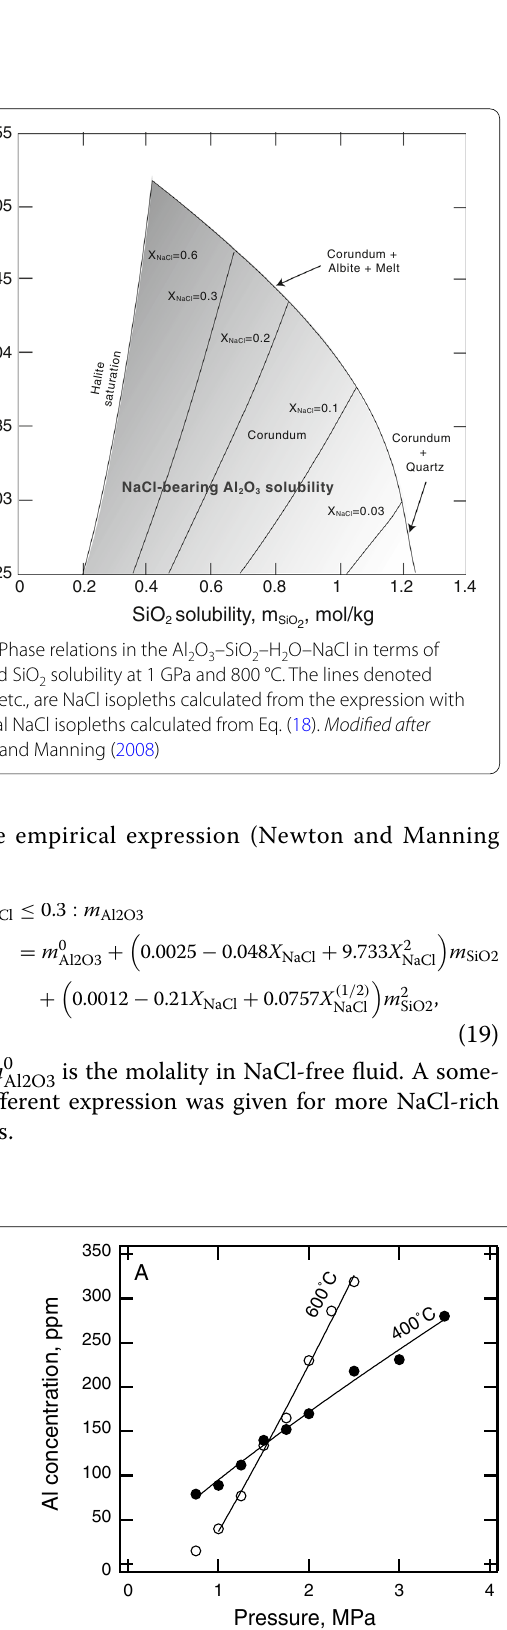
Fig. 21 Solubility in the system NaAlSi 3 O 8 –H 2 O A. Concentration of Al in fluid as a function of pressure at temperatures indicated. B. Concentration of Na in fluid as a function of pressure at temperatures indicated. Modified from Currie